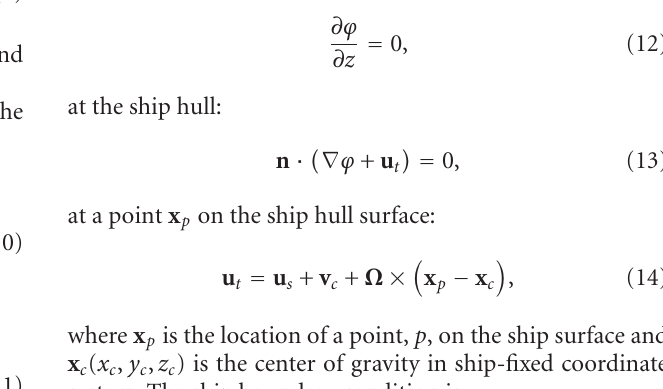
width D , and length L . Except for the free surface and ocean bottom boundaries, all other boundaries are open, which allows fluid to come in and out through these faces. Such boundaries not only allow the use of a small computational domain, but also increase